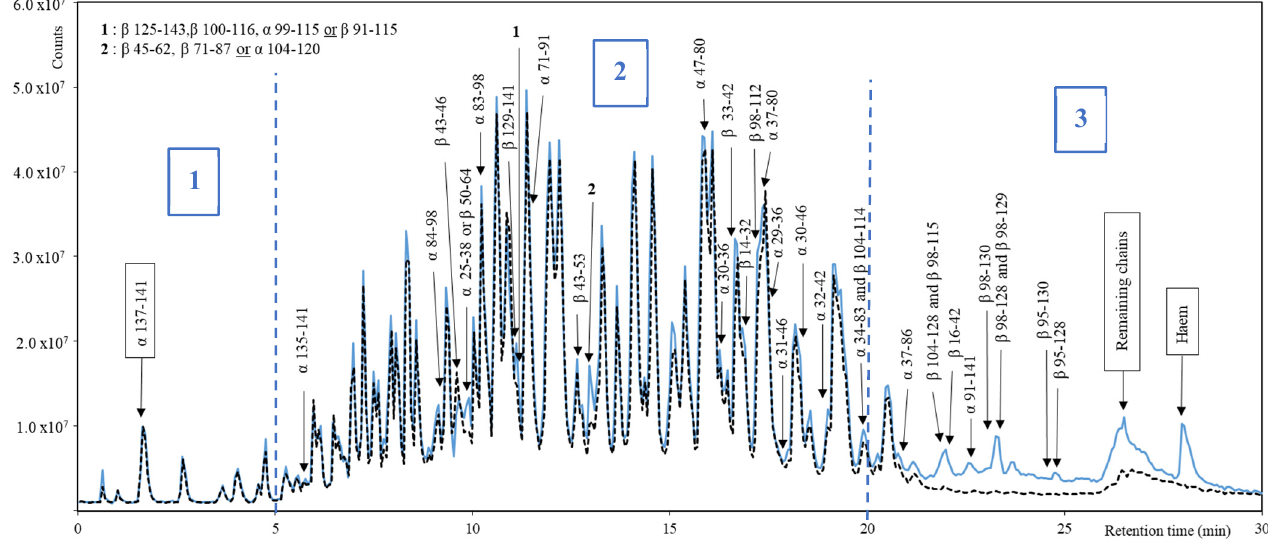
Figure 4. Overlay of the raw (blue plane line) and discolored (black dash line) hydrolysate spectra. Identified sequences found in the raw hydrolysate and the pellet, but absent or diminished in the discolored hydrolysate are presented on the figure with their location on the α or β chain of